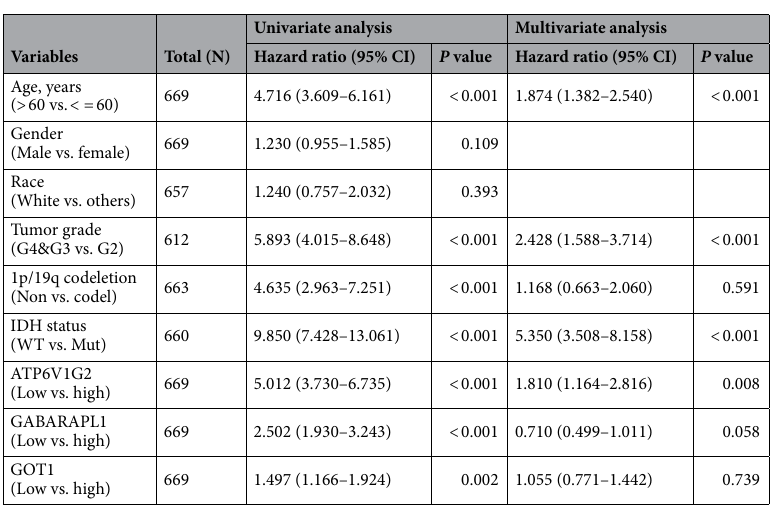
Table 1. Univariate and multivariate Cox regression analysis to identify prognostic factors for glioma patients.